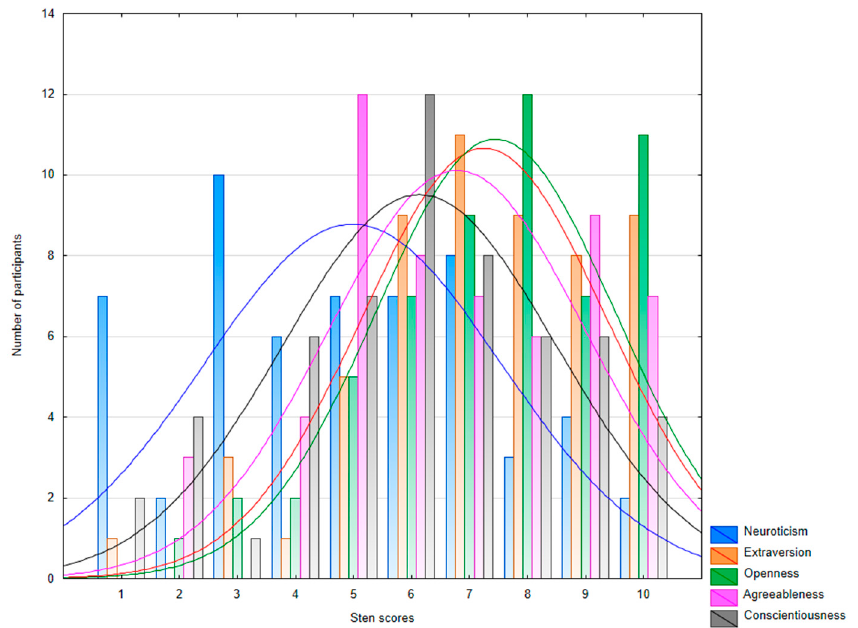
Figure 1. Distribution of NEO-FFI in sten scores.